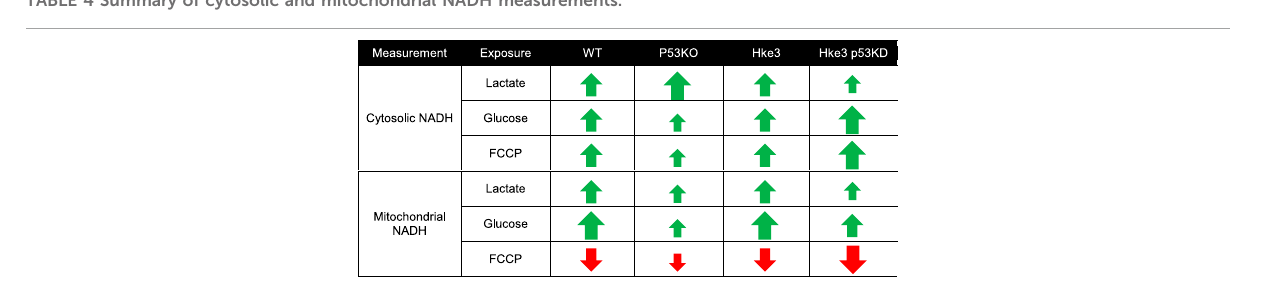
TABLE 4 Summary of cytosolic and mitochondrial NADH